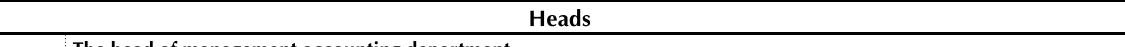
Table 2. Recommended qualification characteristics and duties (powers) of management accounting department employees